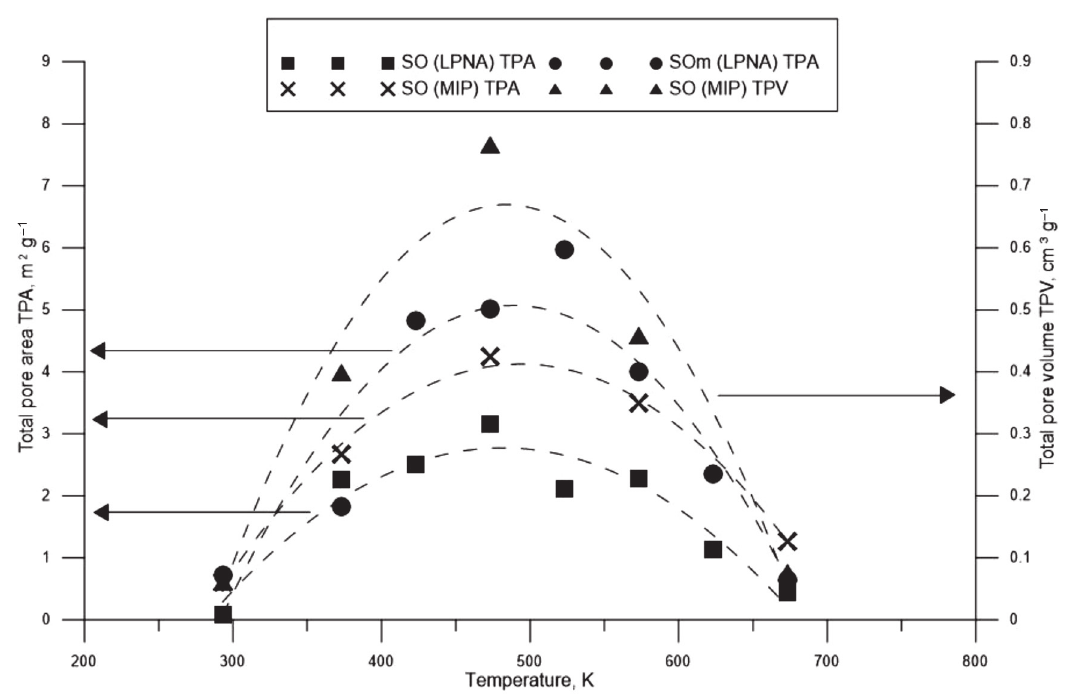
Fig. 5 – Changes in the structural parameters of SO and SOm modified mechanically and thermally